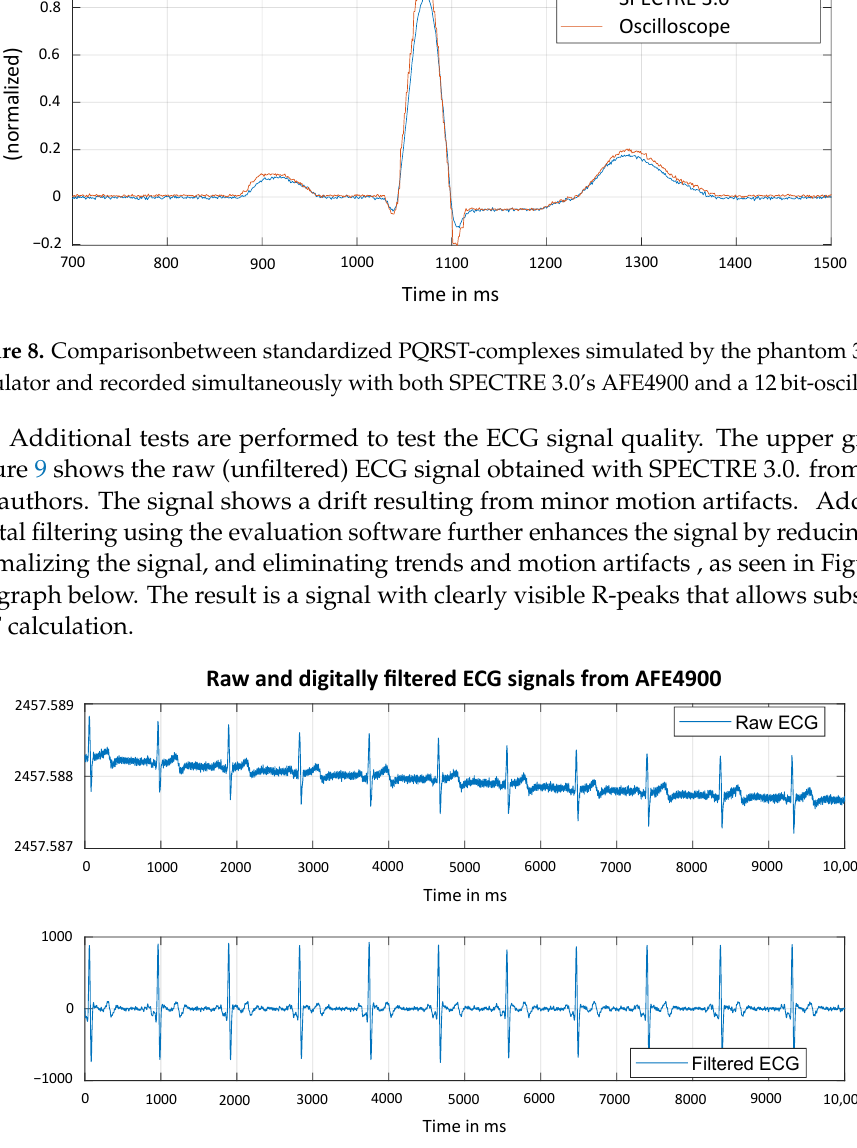
Figure 9. Raw (unfiltered) and digitally filtered ECG signal recorded with SPECTRE 3.0. The heart rate calculated with the MAX30003 data is validated by comparing the displayed value to other methods of heart rate evaluation. First, the ECG-simulator phantom 320 ECG simulator by Müller und Sebastiani Elektronik GmbH is connected to SPECTRE 3.0. The phantom 320 can output various ECG signals with different frequencies. SPECTRE 3.0’s displayed heart rate values match the configured phantom 320 ECG output frequencies. The value is consistent at lower frequencies (i.e., 60 beats per minute (BPM) and lower), whereas a small deviation (up to ± 5 %) can be observed in higher frequencies (i.e., 75 BPM +). Further tests on the authors are performed and the obtained heart rates are compared to the computed values of two other devices: the Apple Watch Series 5